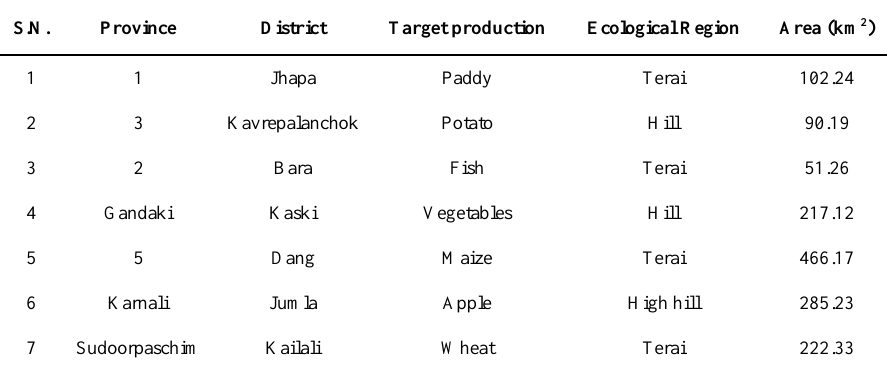
Table 1. Super zones, its target production and area